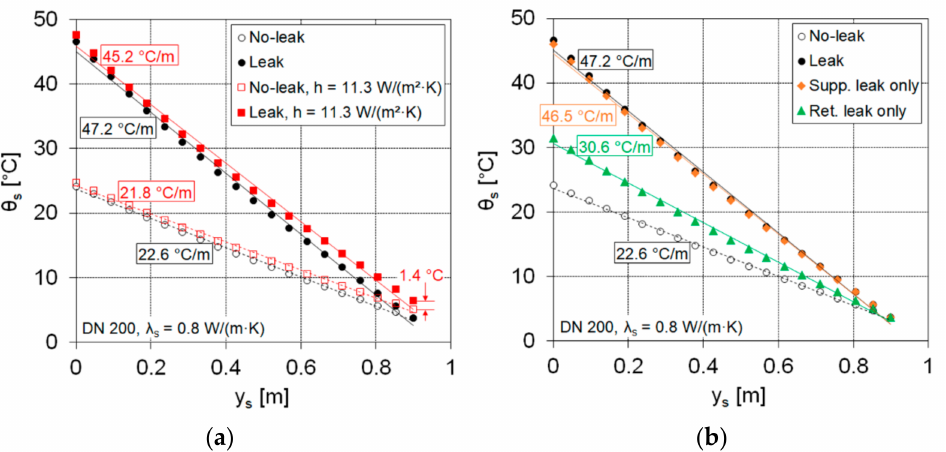
Figure 3. ( a ) Influence of the convection heat transfer at the soil surface (Simulation Case 2) and ( b ) influence of the leakage from supply and return pipe only (Simulation Cases 3 and